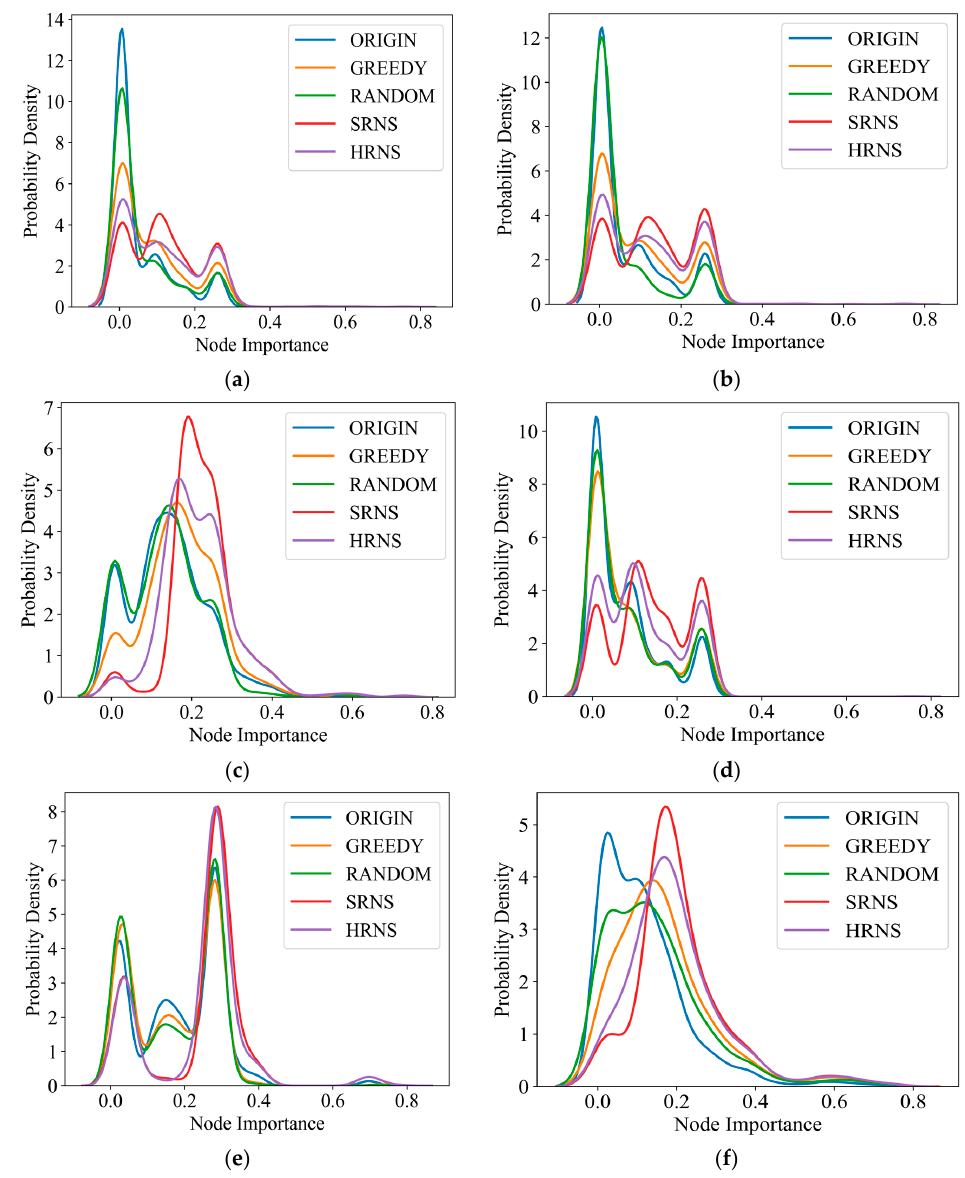
Figure 6. Average node importance with compression ratio. ( a ) PDDI (2000-2). ( b ) PDDI (2500-2). ( c ) PDDI (blog). ( d ) PDDI (cora). ( e ) PDDI (Ca-GrQc). ( f ) PDDI (UCforum).